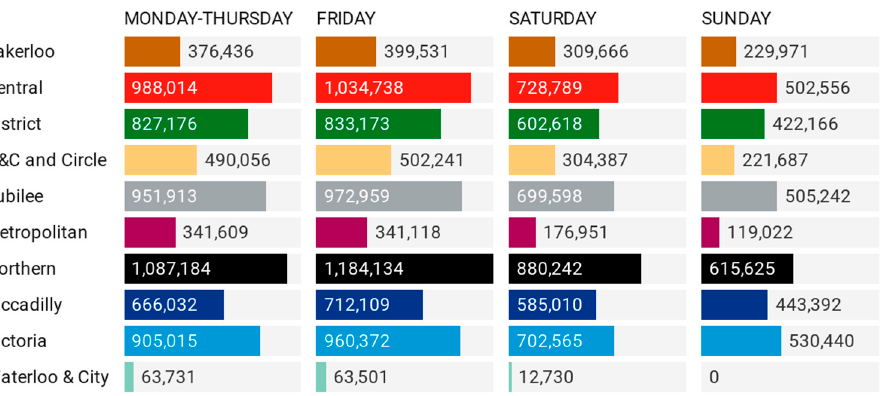
1.5 Figure 9. Linear regression of passengers per service versus line stations ( left ) and line length ( right ).